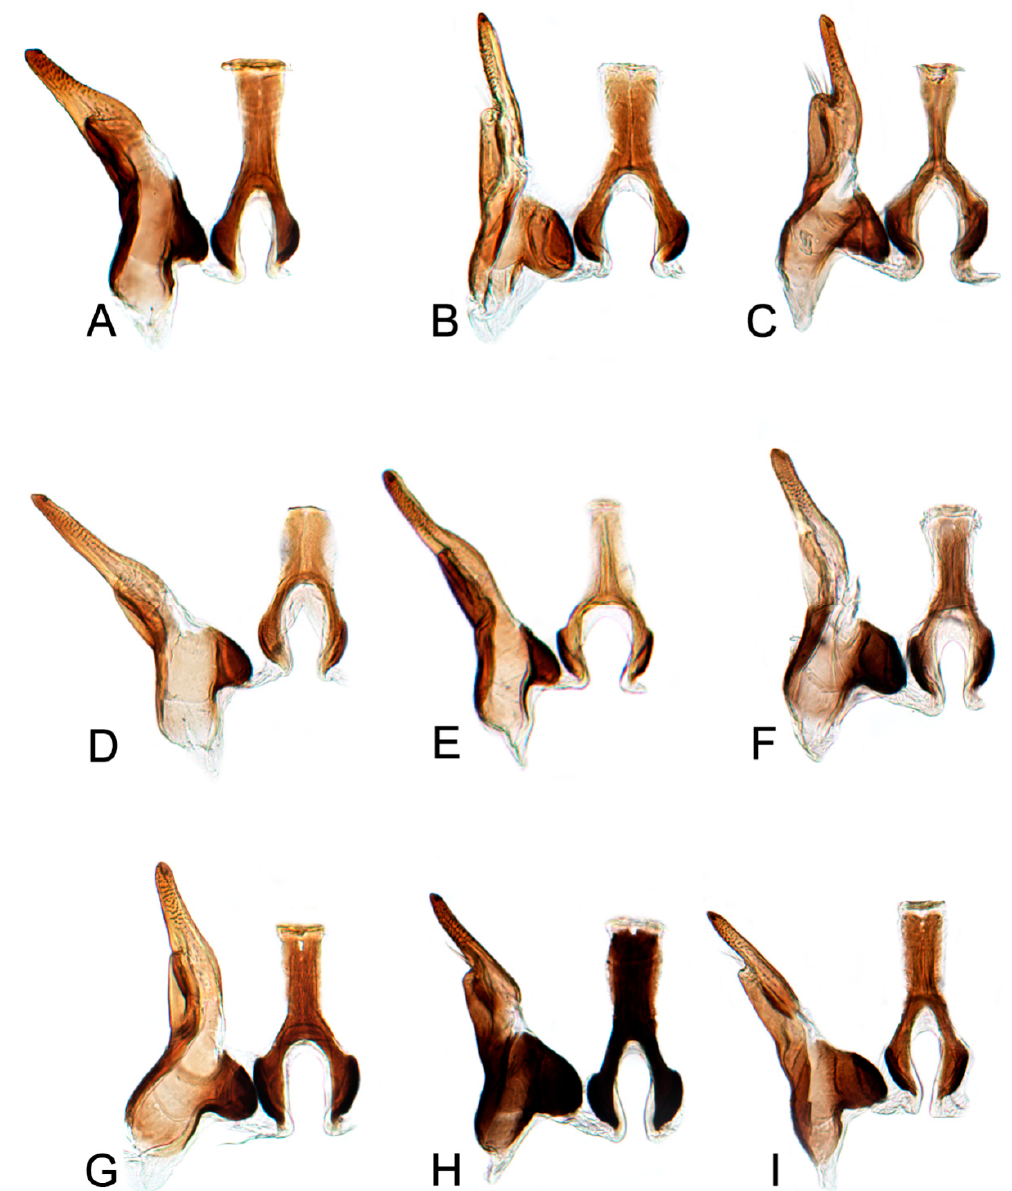
Figure 16. Style and connective, ventral view: ( A ) H. viraktamathiellus ; ( B ) H. triangulus ; ( C ) H. concavus ; ( D ) H. dietrichi ; ( E ) H. bucephalus ; ( F ) H. fletcheri ; ( G ) H. dichotomous ; ( H ) H. sellatus ; and ( I ) H. rectus .